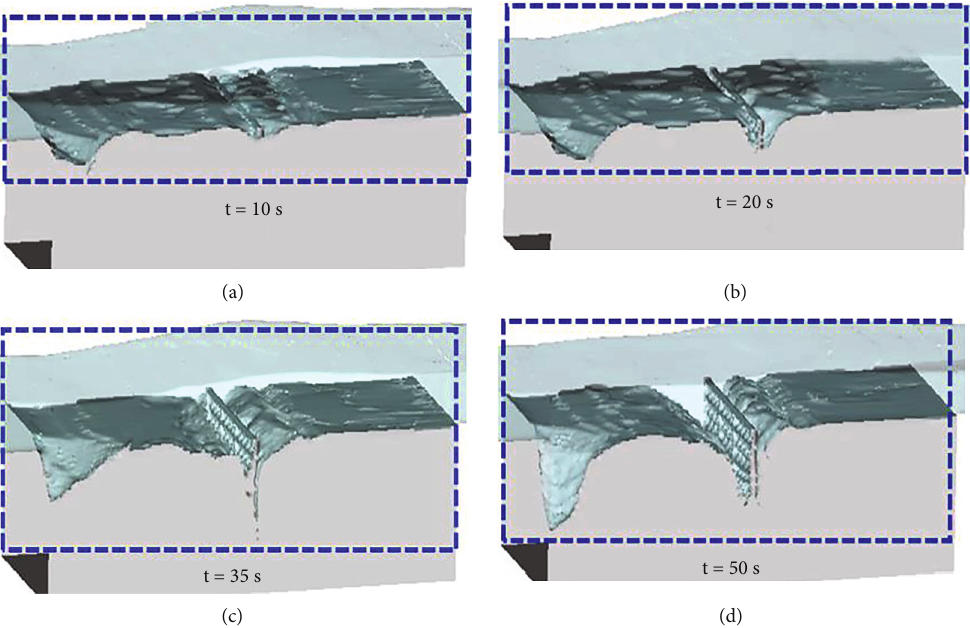
Figure 14: A series of demonstrations of the erosion destruction process at (a) the simulation time =10 s, (b) the simulation time =20 s, (c) the simulation time=35, s and (d) the simulation time =50 s.